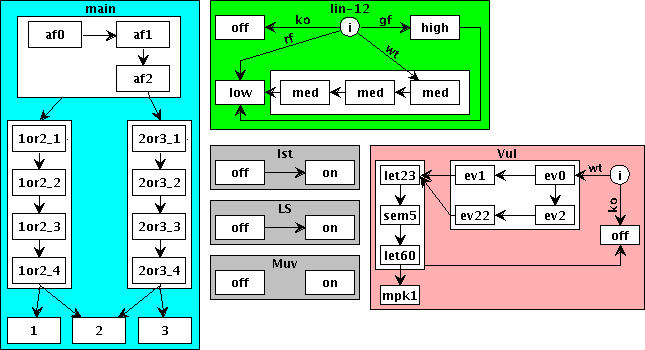
Graphic Visualization of the VPC ModuleEach rectangle represents a possible value, and arrows represent possible value changes (according to conditions on values of other components). The “main” component follows the progress of the cell toward fate assumption. The cell starts as undifferentiated (af); according to the activities in the EGFR and LIN-12 / Notch pathways, it decides whether to adopt a vulval (1or2) or a nonvulval (2or3) cell fate. Finally, the cell assumes one of the three cell fates. The smaller rectangles correspond to time delays until these decisions are made. Other components represent the activity level of the biological components they are associated with (lin-12, EGFR pathway, lst genes, LS, lin-15). Our tool also enables visualization of executions of this model by highlighting the current value of each component. Changes in highlighted values allow us to follow the execution visually.